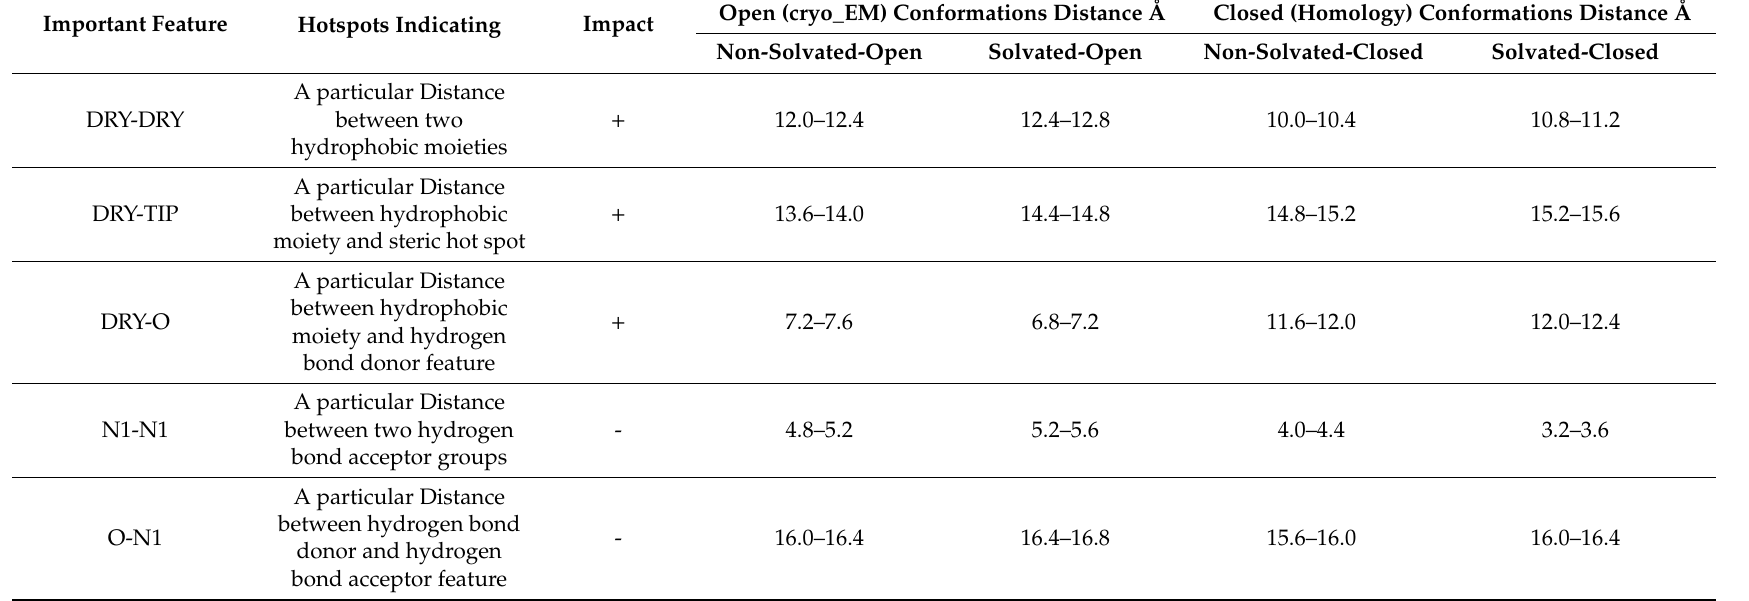
Table 3. Summarizing GRIND features and their mutual distances in hERG open and closed solvated and non-solvated states and their impact on hERG inhibitory